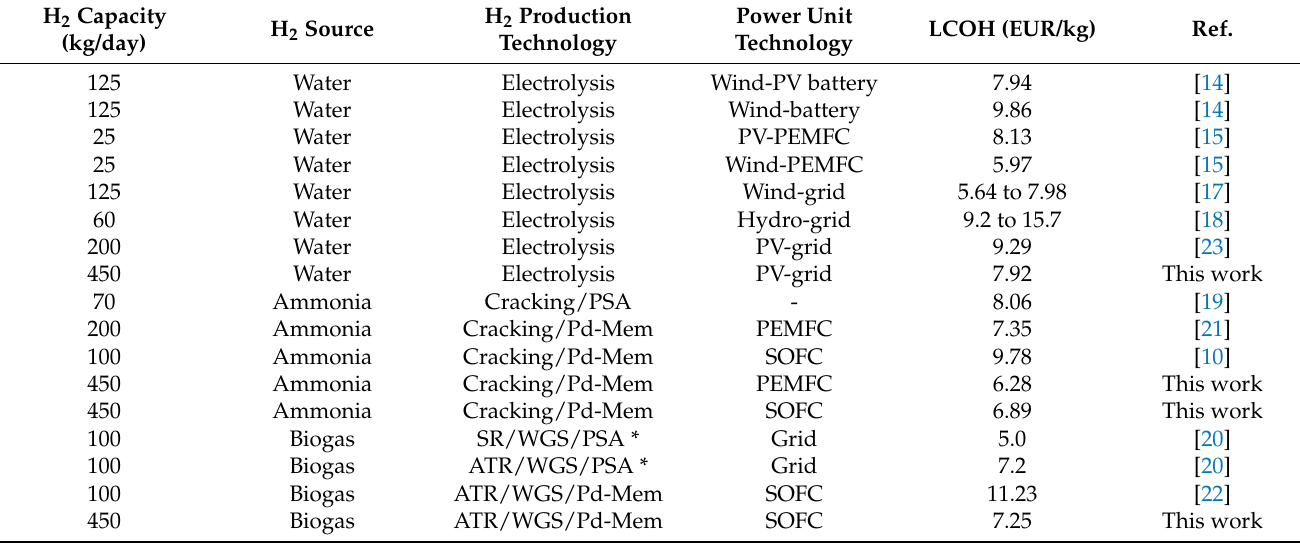
Table 3. Comparison of results with literature